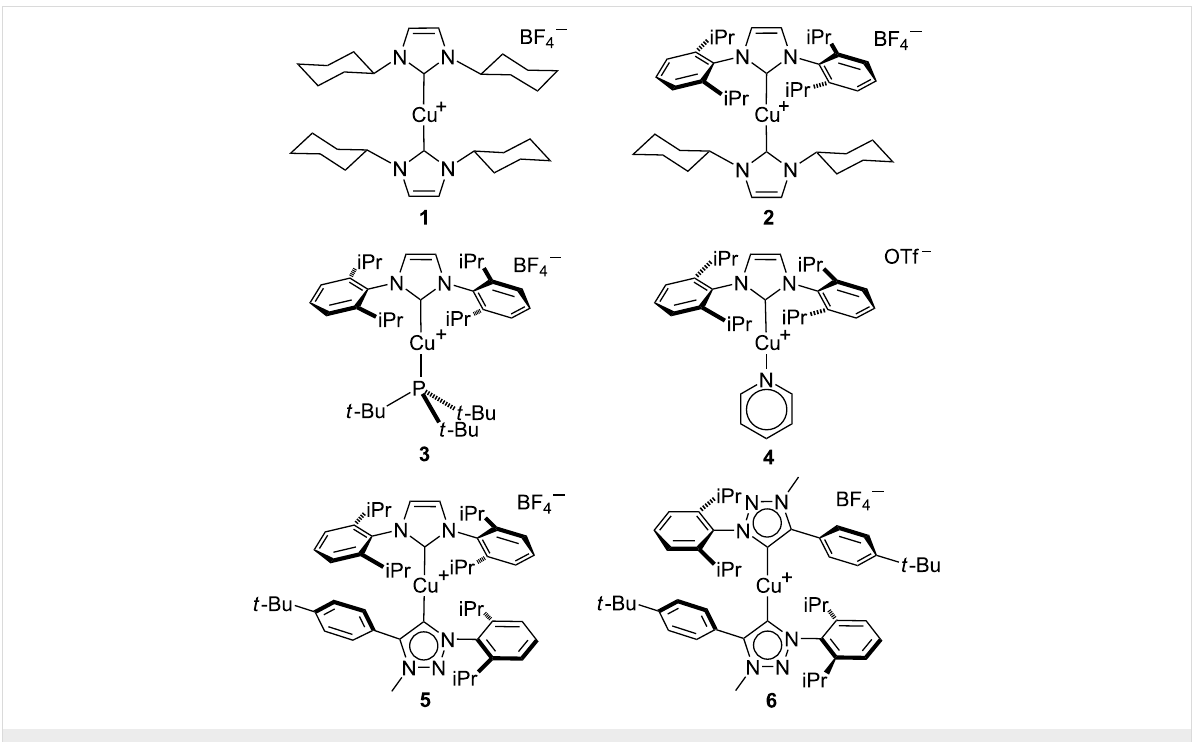
Figure 1: Catalytic systems used in this study.